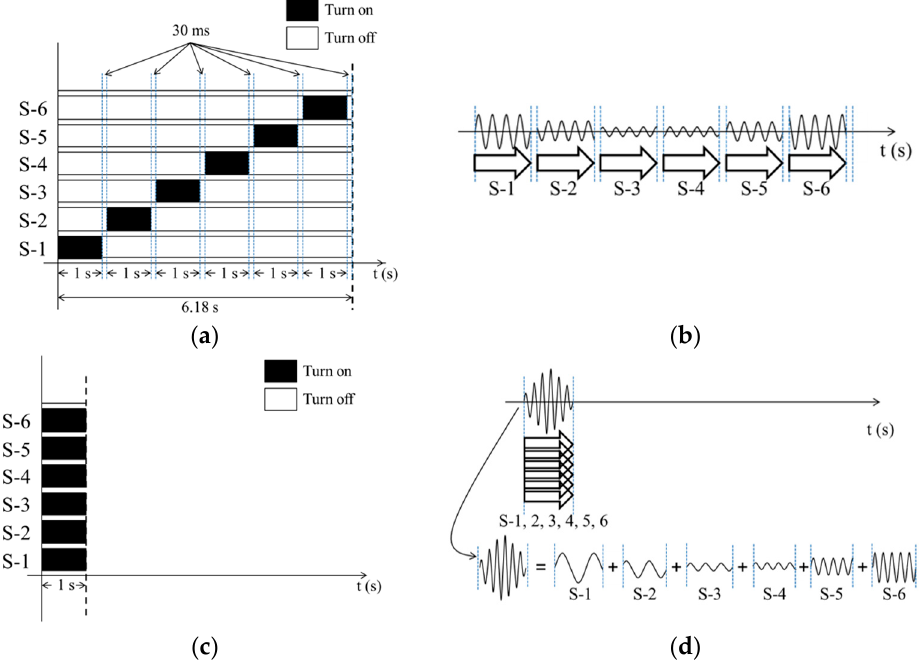
Figure 2. ( a ) Source illumination sequence and ( b ) data acquisition charts of TDM. ( c ) Source illumination sequence and ( d ) data acquisition charts of FDM.